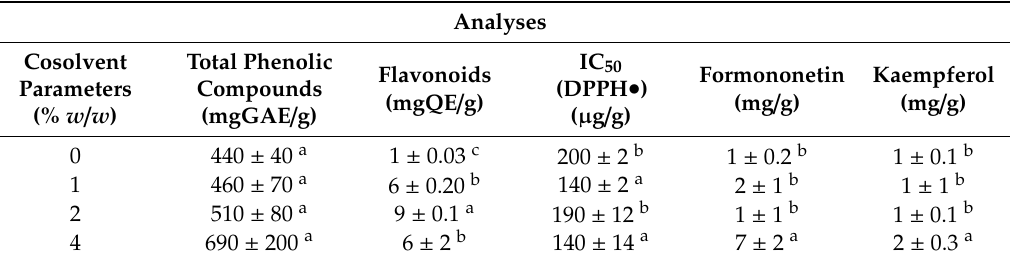
Table 2. Results of the yields of total phenolic compounds (mg GAE / g), flavonoids (mg QE / g), IC 50 (DPPH.) ( µ g / g), and the biomarkers formononetin (mg / g) and kaempferol (mg / g) using 1, 2 and 4% ethanol (cosolvent) in relation to the mass of CO 2 ( w / w ) and without the presence of